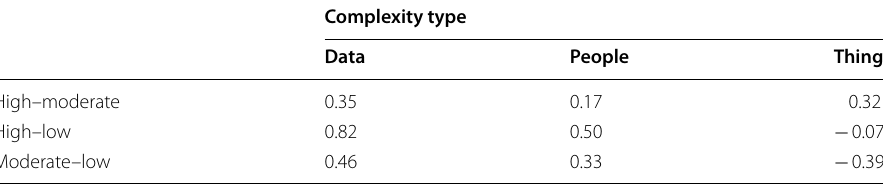
Numeracy scores across levels of